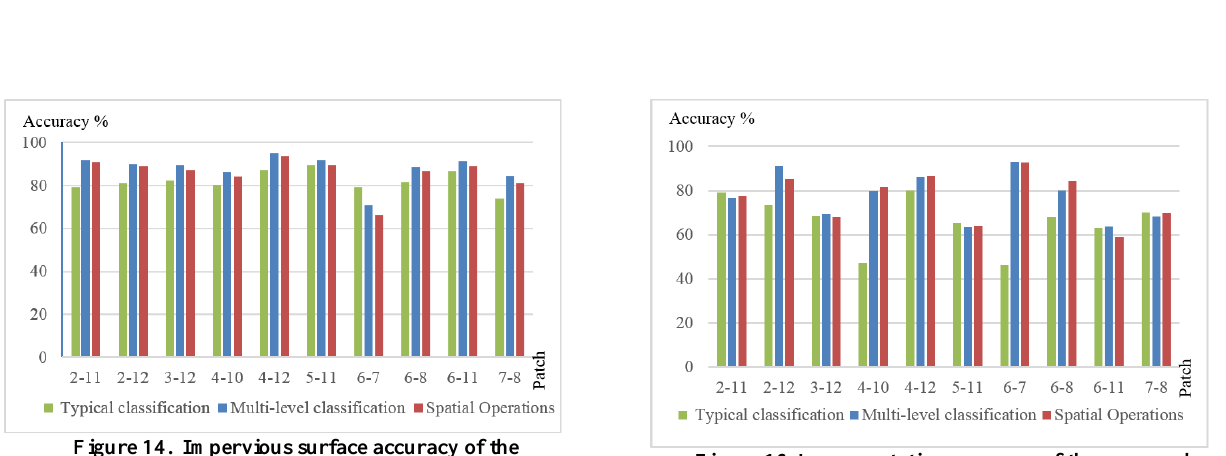
Figure 16. Low vegetation accuracy of the proposed method in test patches.